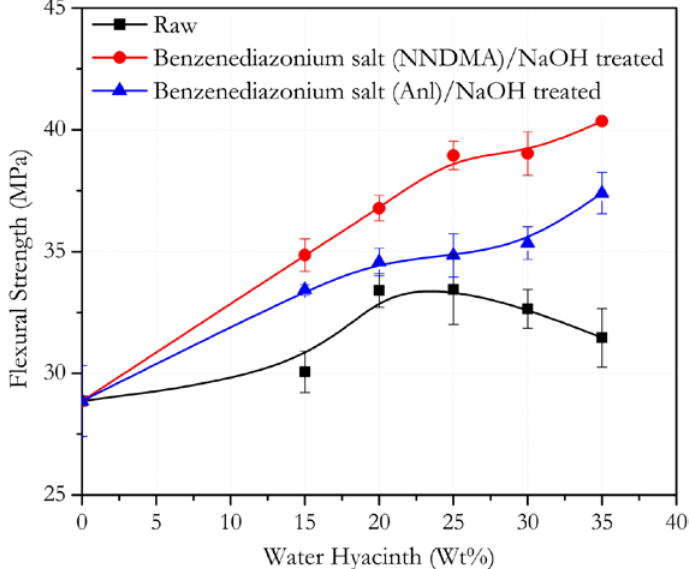
Figure 5: Flexural strength as function of fiber loading in WH-PP